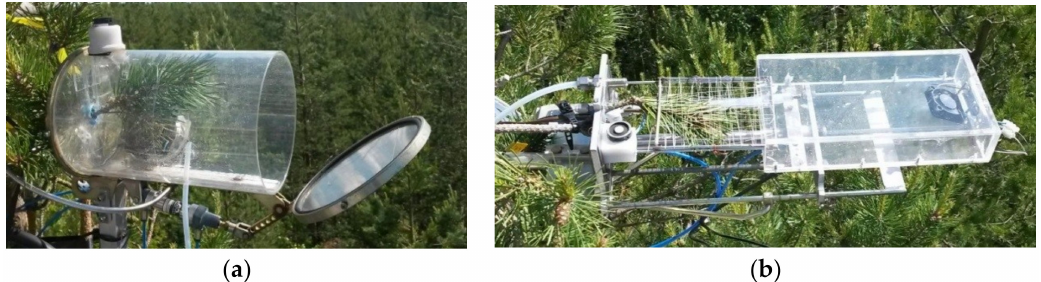
Figure 1. Shoot chamber with ( a ) undeformed, and ( b ) flattened shoots in the open position. The measurements were used to determine shoot net assimilation ( A ) in units of grams of CO 2